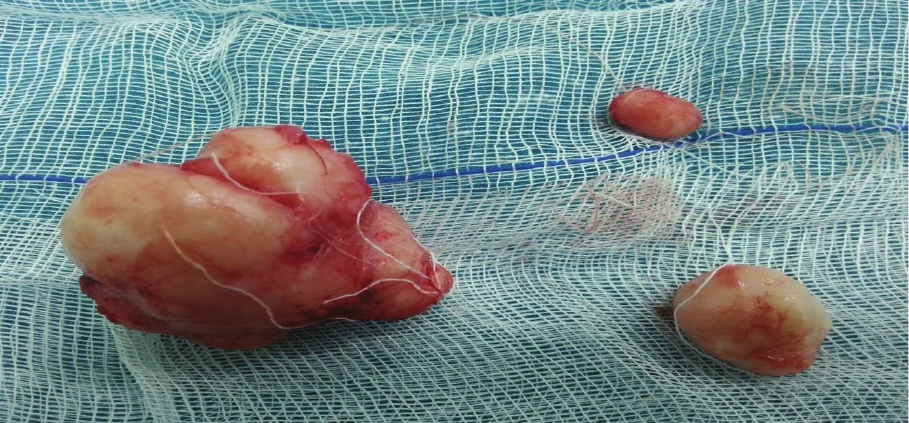
Figure 2: Pathological specimens.